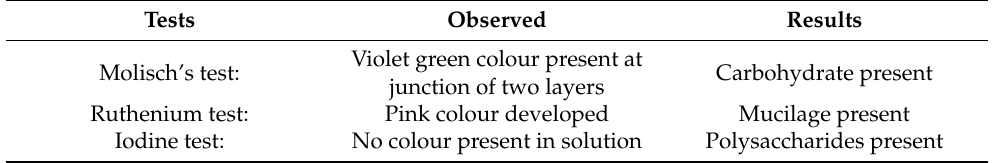
Table 3. Identification test results of the mucilage.